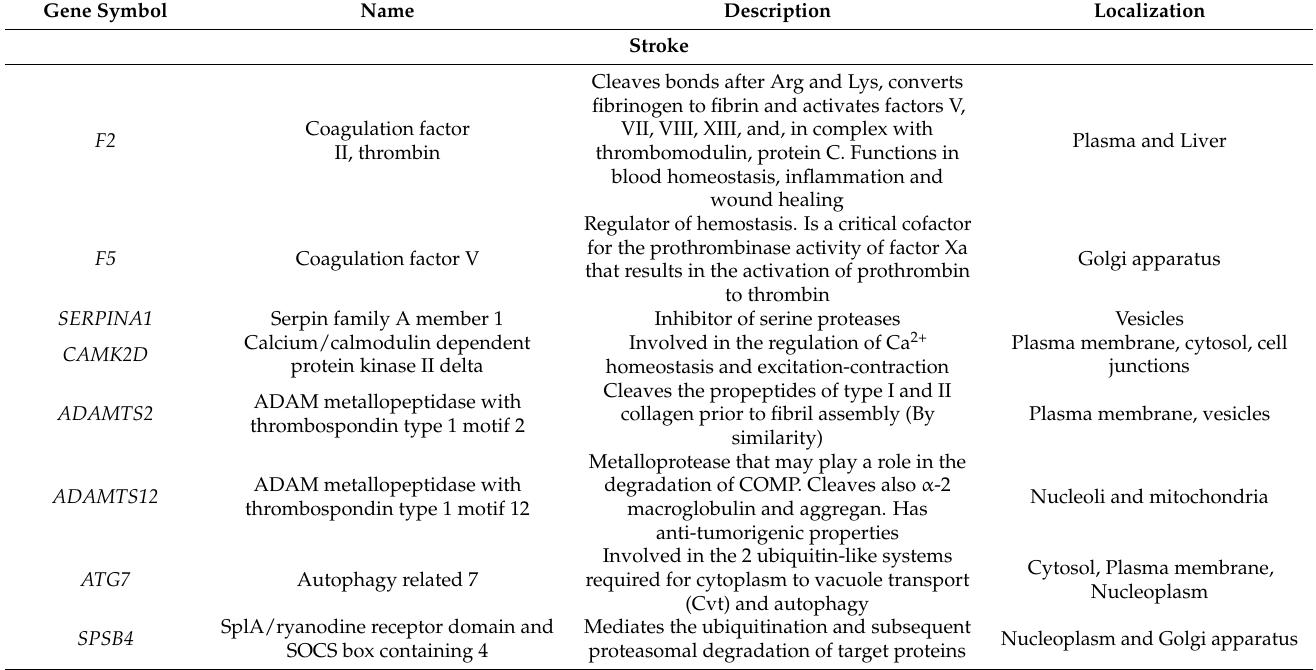
Figure 1. PPI network between stroke and periodontitis relevant proteins at the highest confidence cut-off of 0.9 in this network. Mapped genes for stroke and periodontitis are coloured in orange and red, respectively. Table 2. Details of the identified genes in the interaction between stroke and periodontitis. Gene